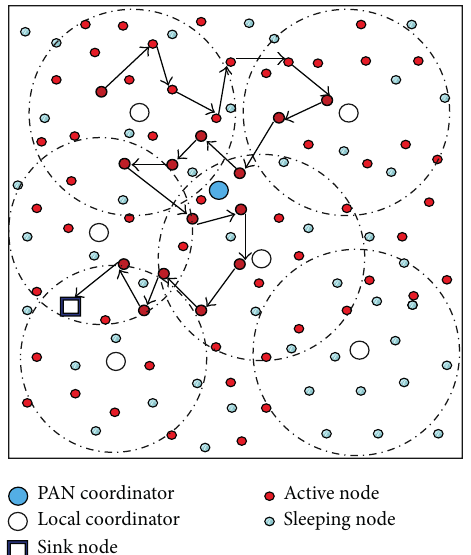
Figure 1: Random walk routing in a WSN with PAN Coordinators.